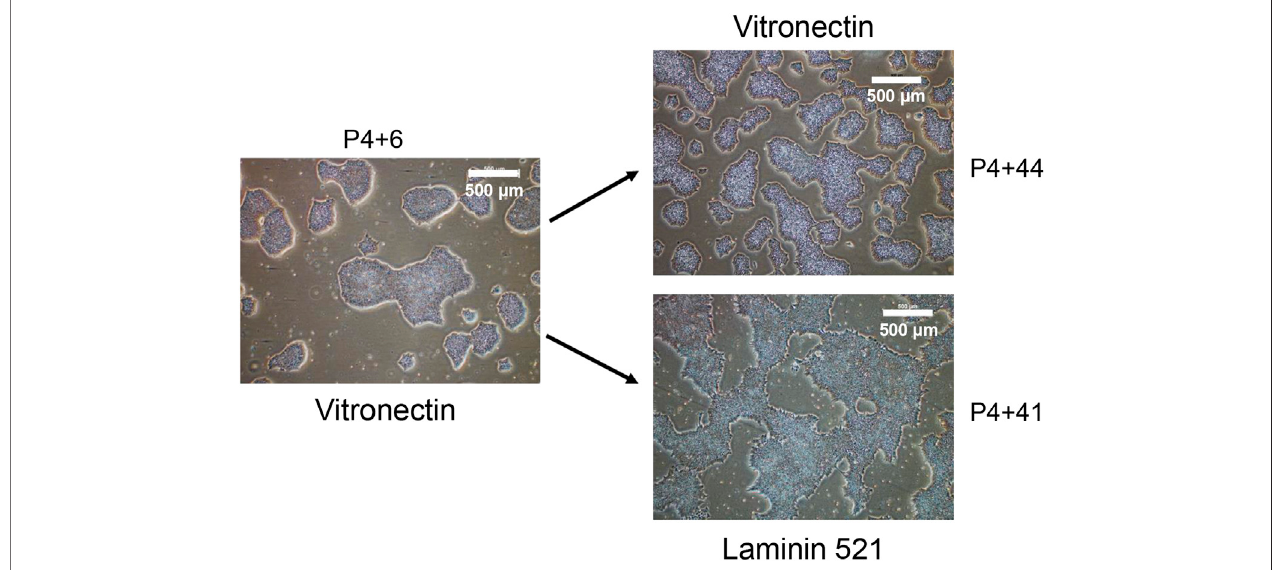
FIGURE4| Themorphology ofiPSCcoloniesat early and latepassagenumber. The generated iPSC celllinewasmaintainedin parallel onVitronectinand Laminin 521 coated fl asks. P4 refers to the fi rst 4 manual passages, with subsequent passages performed in bulk using Versene.